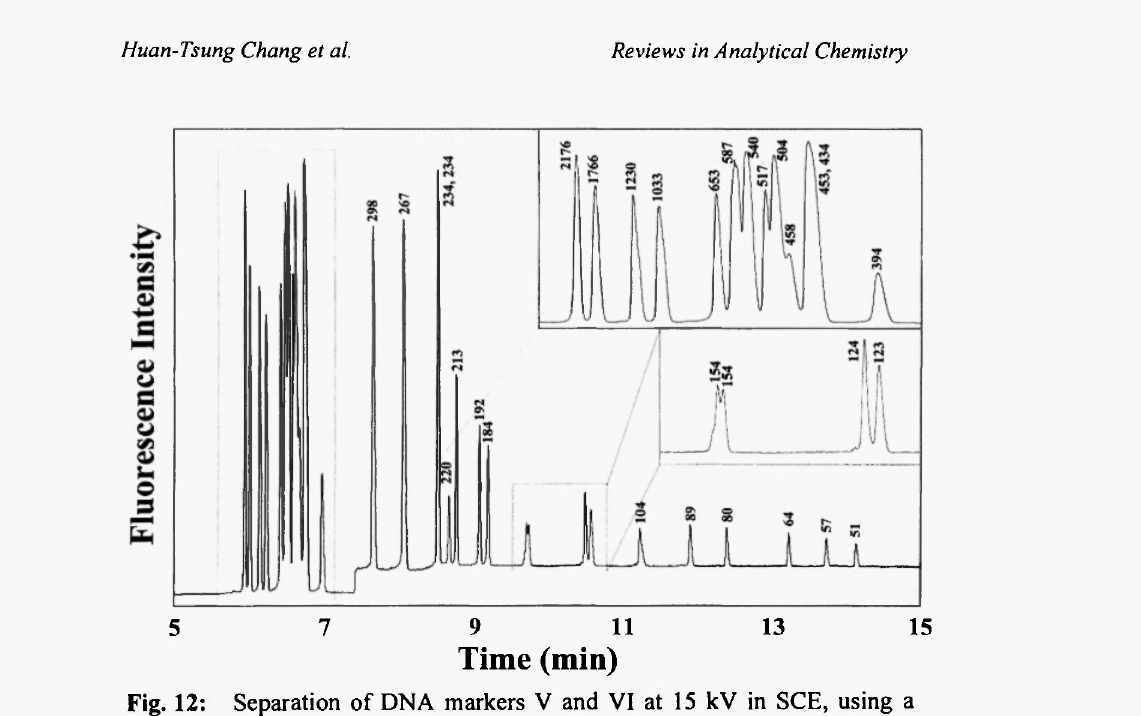
Fig. 12: Separation of DNA markers V and VI at 15 kV in SCE, using a 1% PEO solution containing ^ g / mL EB for 4 min, then a 2% PEO solution containing 20 μg/mL EB for the rest of the separation. Buffer vials contain the 2% PEO and 2(^g/mL EB solution. Other conditions as in Fig. 9. (Adapted with permission from Ref.